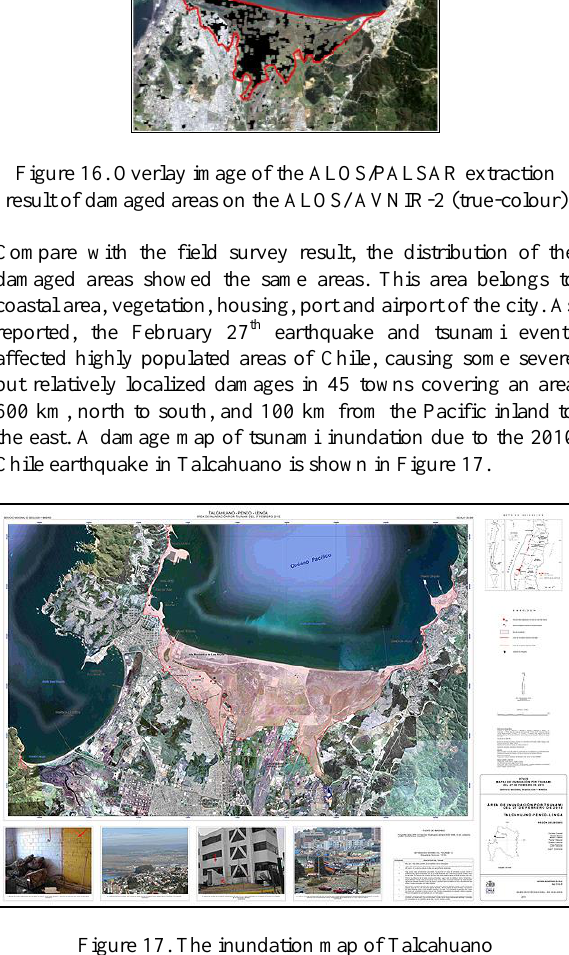
Figure 17. The inundation map of Talcahuano (Creixell, et.al,